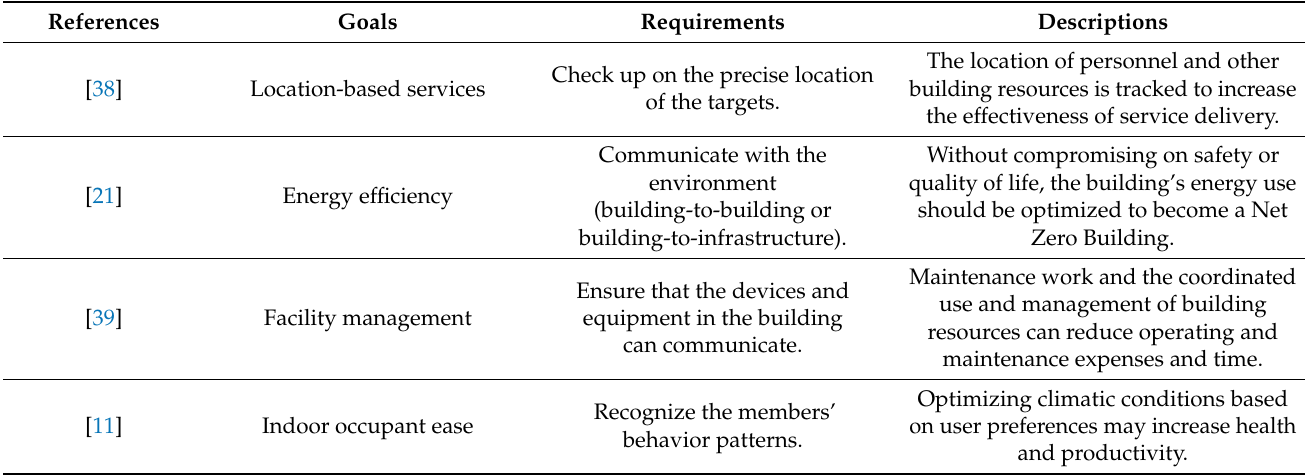
Table 2. The major goals of intelligent